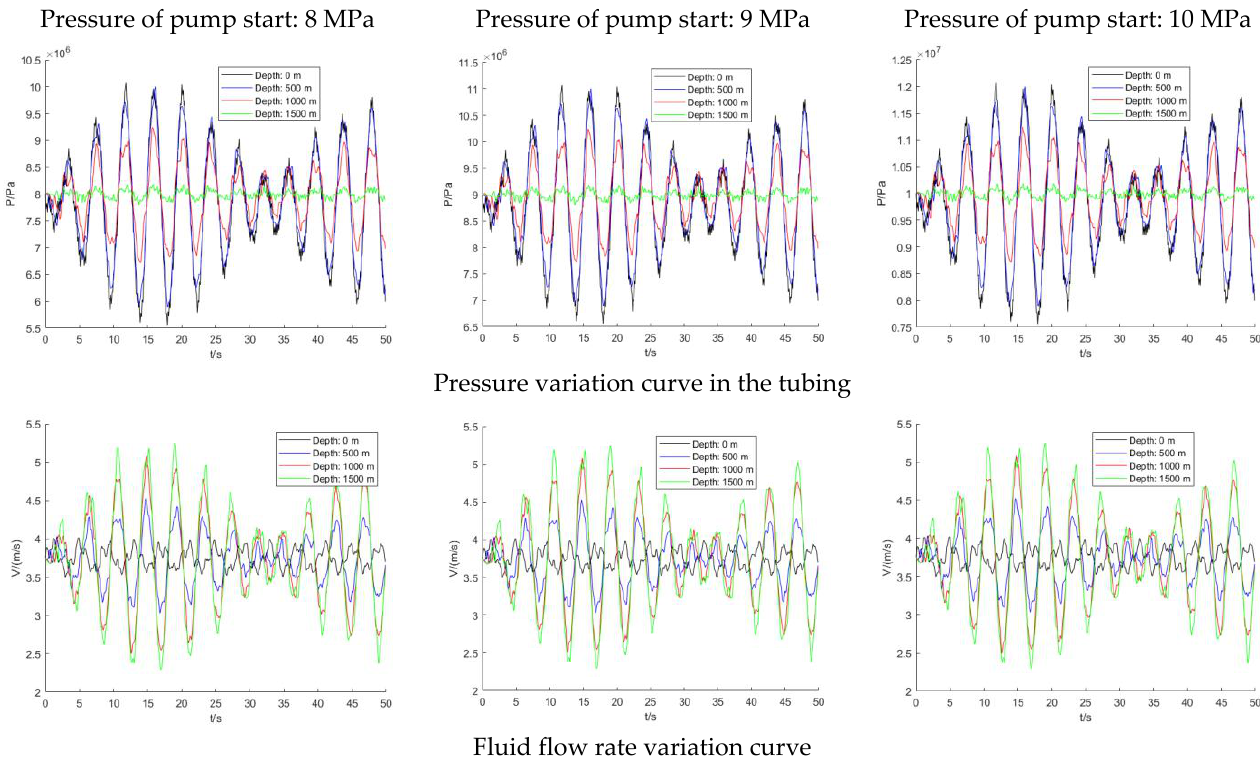
Figure 2. Variation curves of flow field parameters at different initial pump start pressures.